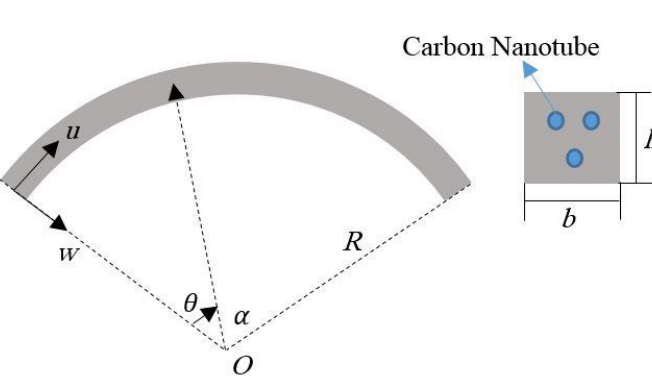
Molecules 2018 , 23 , x FOR PEER REVIEW